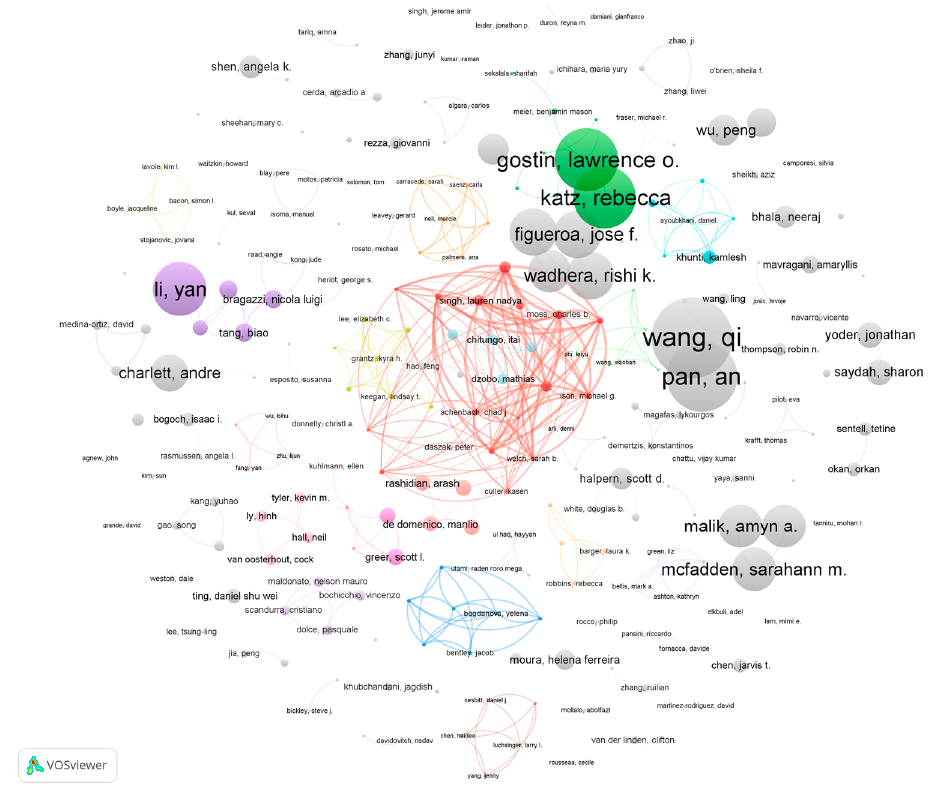
Figure 5. The co-authorship network of authors (citations). Note(s): The node size represents the frequency of citations. The colours of nodes refer to clusters. The links refer to co-authorship. Table 7. The top five authors with highest